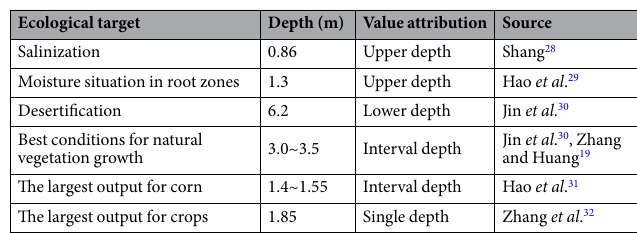
Table 2. Groundwater depths for ecological